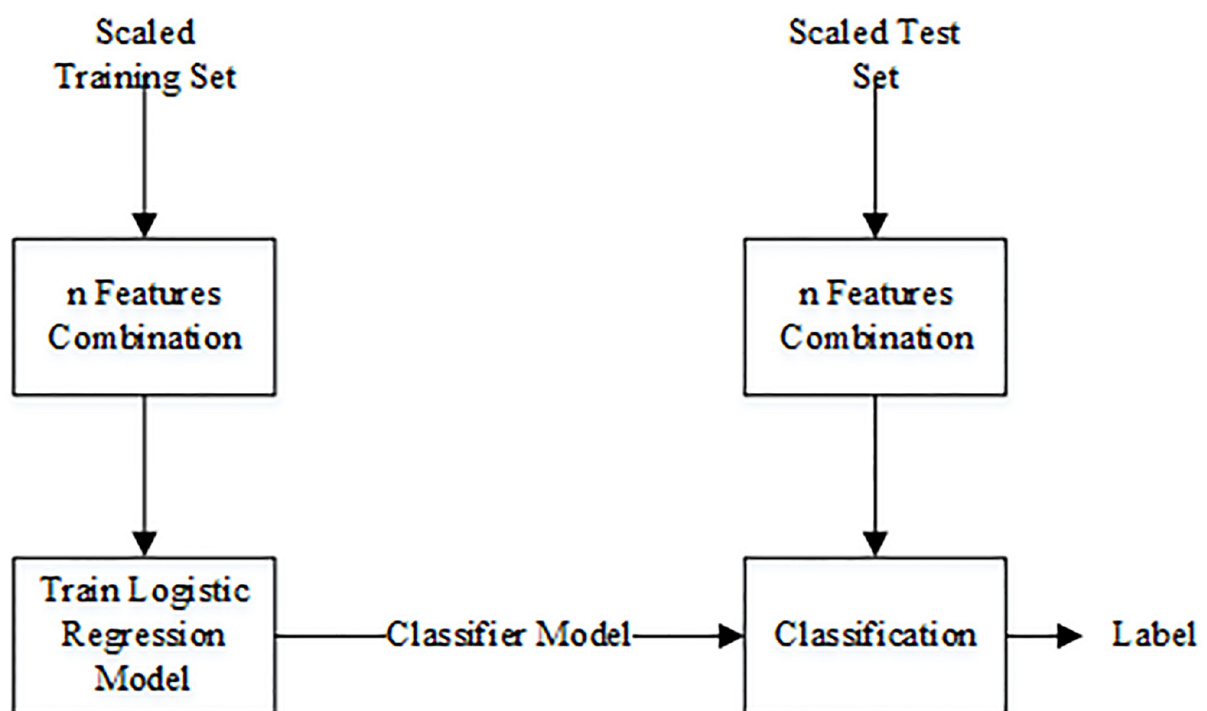
Fig 3. Flowchart for classification of wheeze and normal respiratory sounds using combination of features.